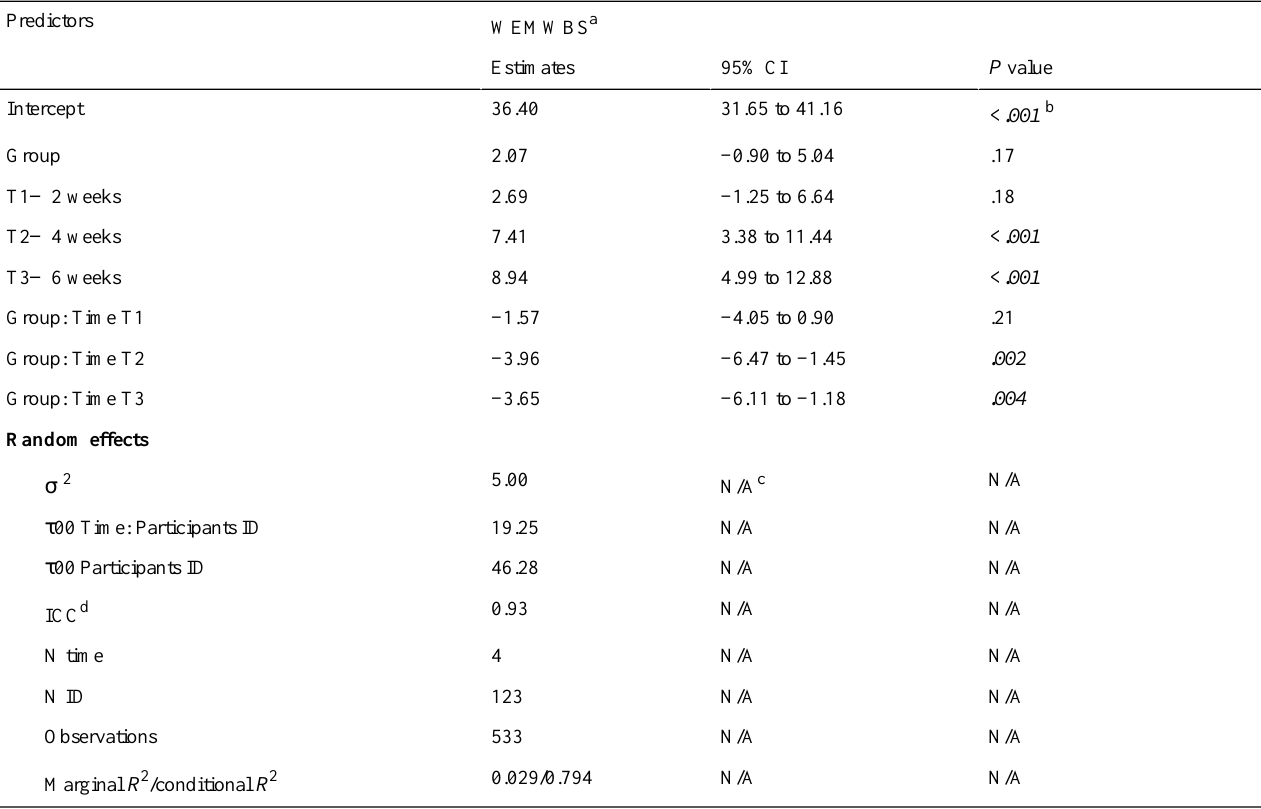
Table 4. Summary of the linear-mixed model on Warwick-Edinburgh Mental Well-Being Scale scores over the 4 time points in the intervention and waitlist control